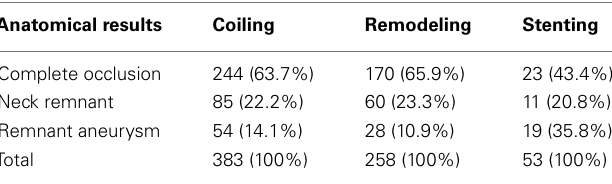
Table 2 | Immediate anatomical results by treatment technique, ATENA study (Pierot et al.,